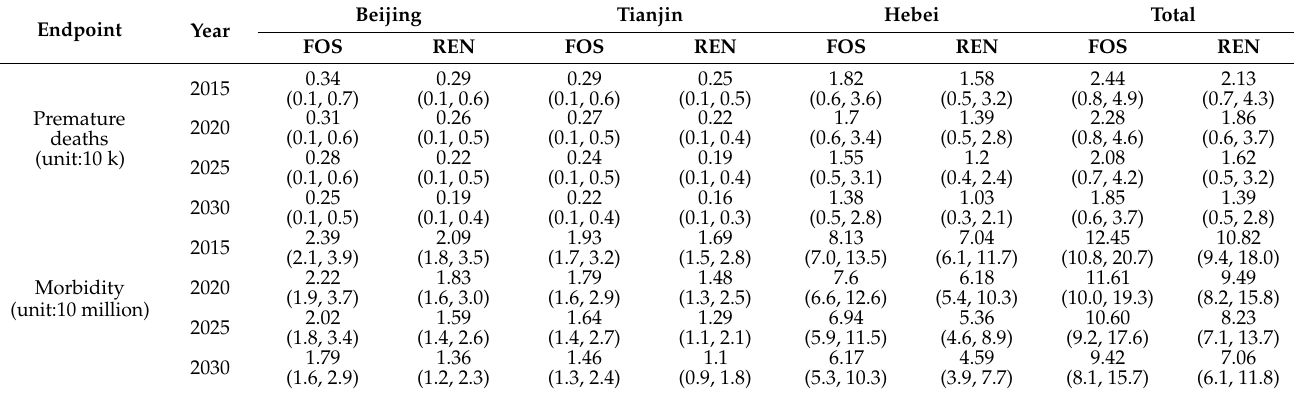
Table 6. Premature deaths and morbidity in the BTH region 1 .